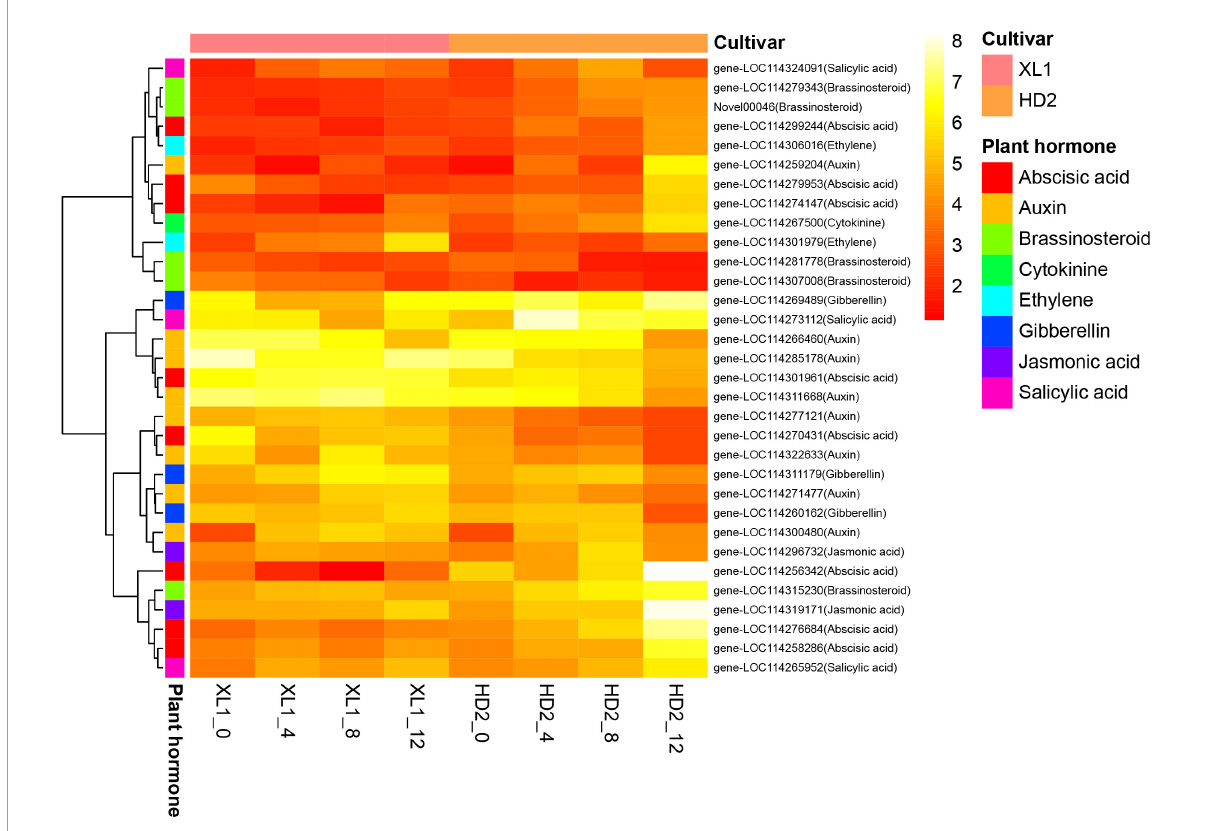
FIGURE7 The heatmap of differentially expressed genes (DEGs) involve in the Plant hormone signal transduction pathway. The heatmap was generated from the log 2 (FPKM + 1) of three replicates for each sample, and the values of clustering distance were “correlation” and the clustering algorithms was